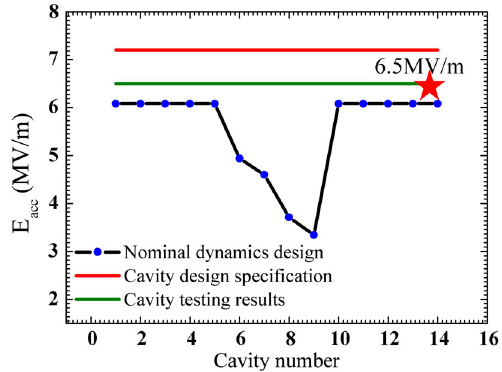
FIG. 8. The E specifications (red line), the horizontal testing acc results (green line) and the current design (dotted line) of the Spoke012 cavities.